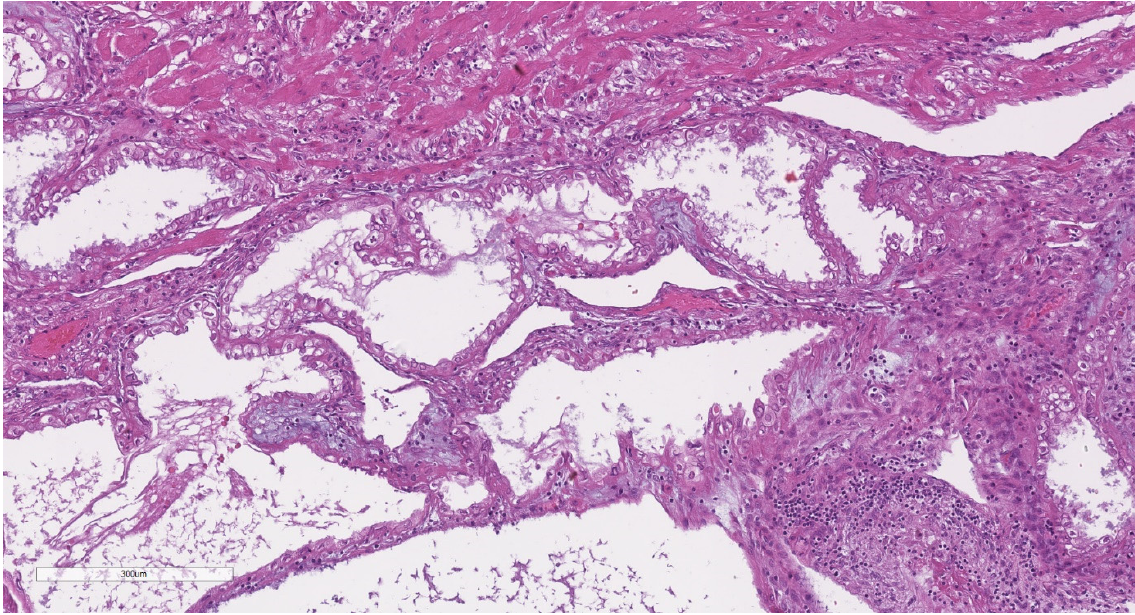
Figure 5. H&E, 10×. The glandular cells of the decidualized endometrium in the adenomyosis foci shows hypersecretive features, such as a clear cytoplasm.